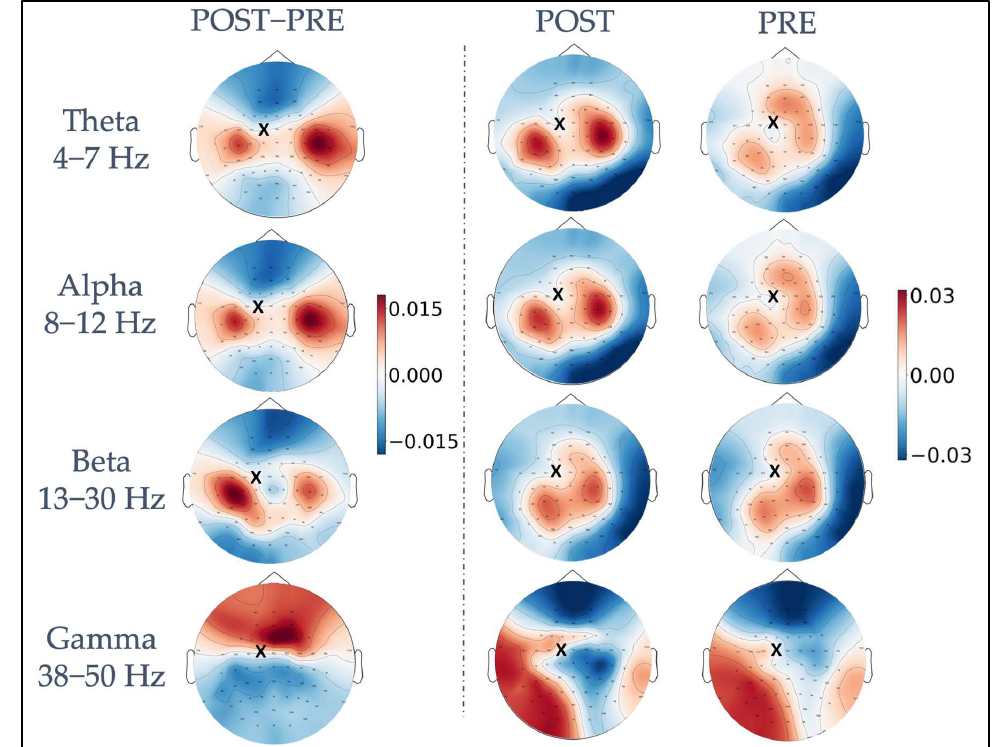
Figure 2. Representation of TMS-induced functional connectivity modulation in the theta, alpha, beta, and gamma frequency bands. The first column shows the difference in iPLV between post-stimulus and pre-stimulus conditions, calculated between the FC1 stimulation site (indicated with a black x) and the whole brain. In the second and third columns, post-stimulus iPLV and pre-stimulus iPLV are represented, respectively.